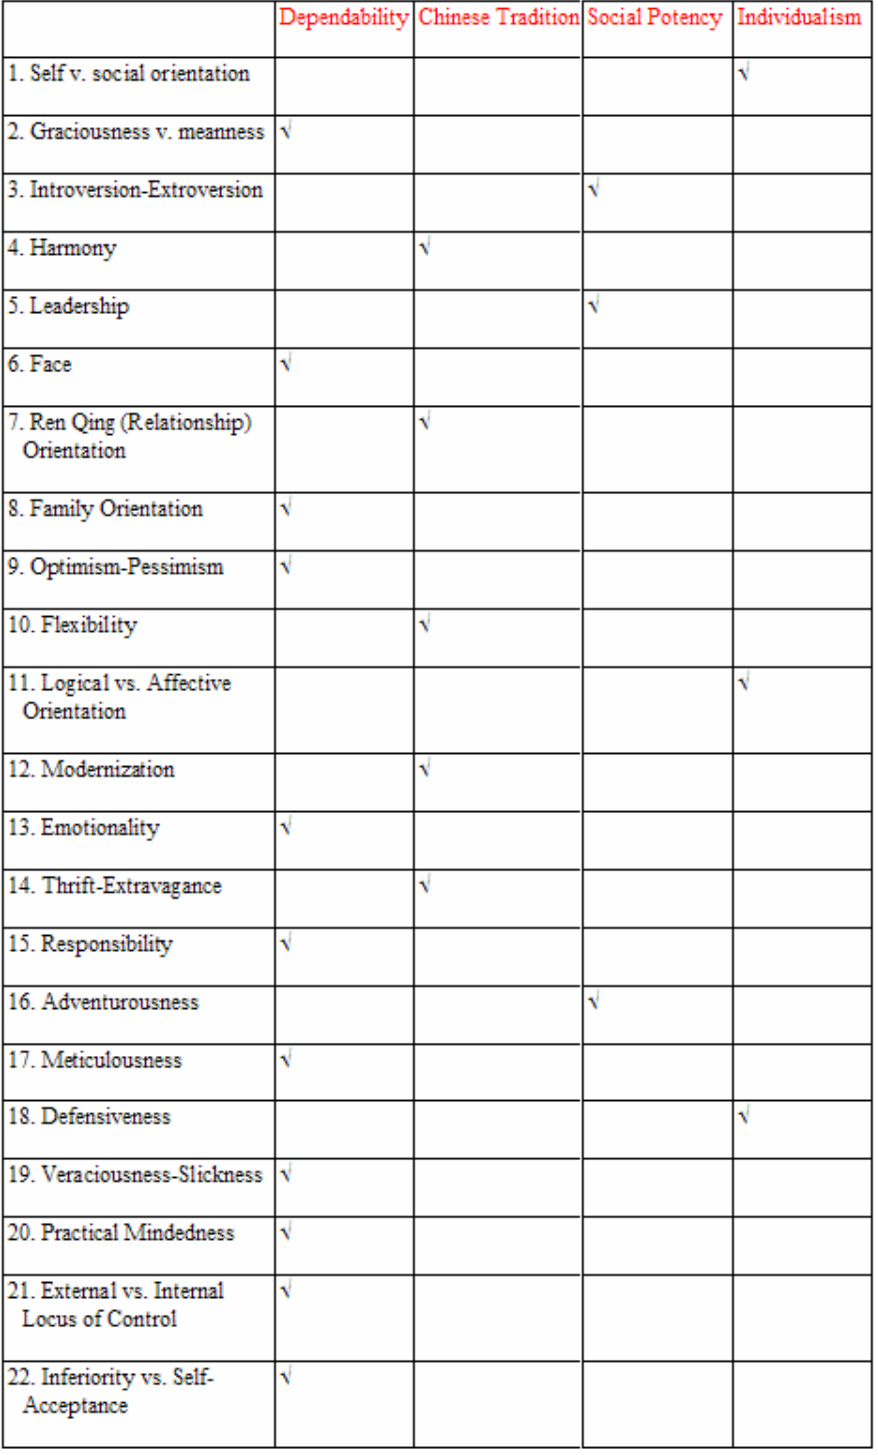
Table 1. Categorization of the 22 Personality Dimensions on the